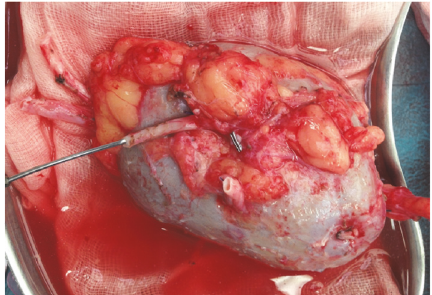
Figure 3: Left pelvic kidney with additional upper polar artery and an additional middle polar artery before reconstruction.